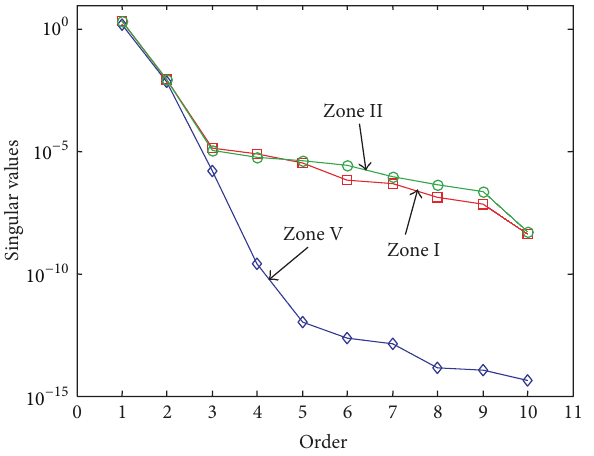
Figure 6: Singular values of zones I, II, and V.